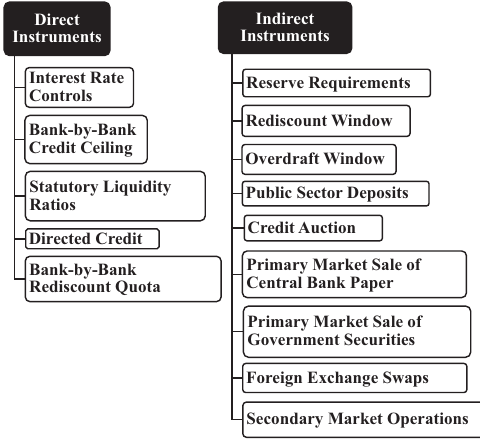
Figure 1. Direct and indirect instruments